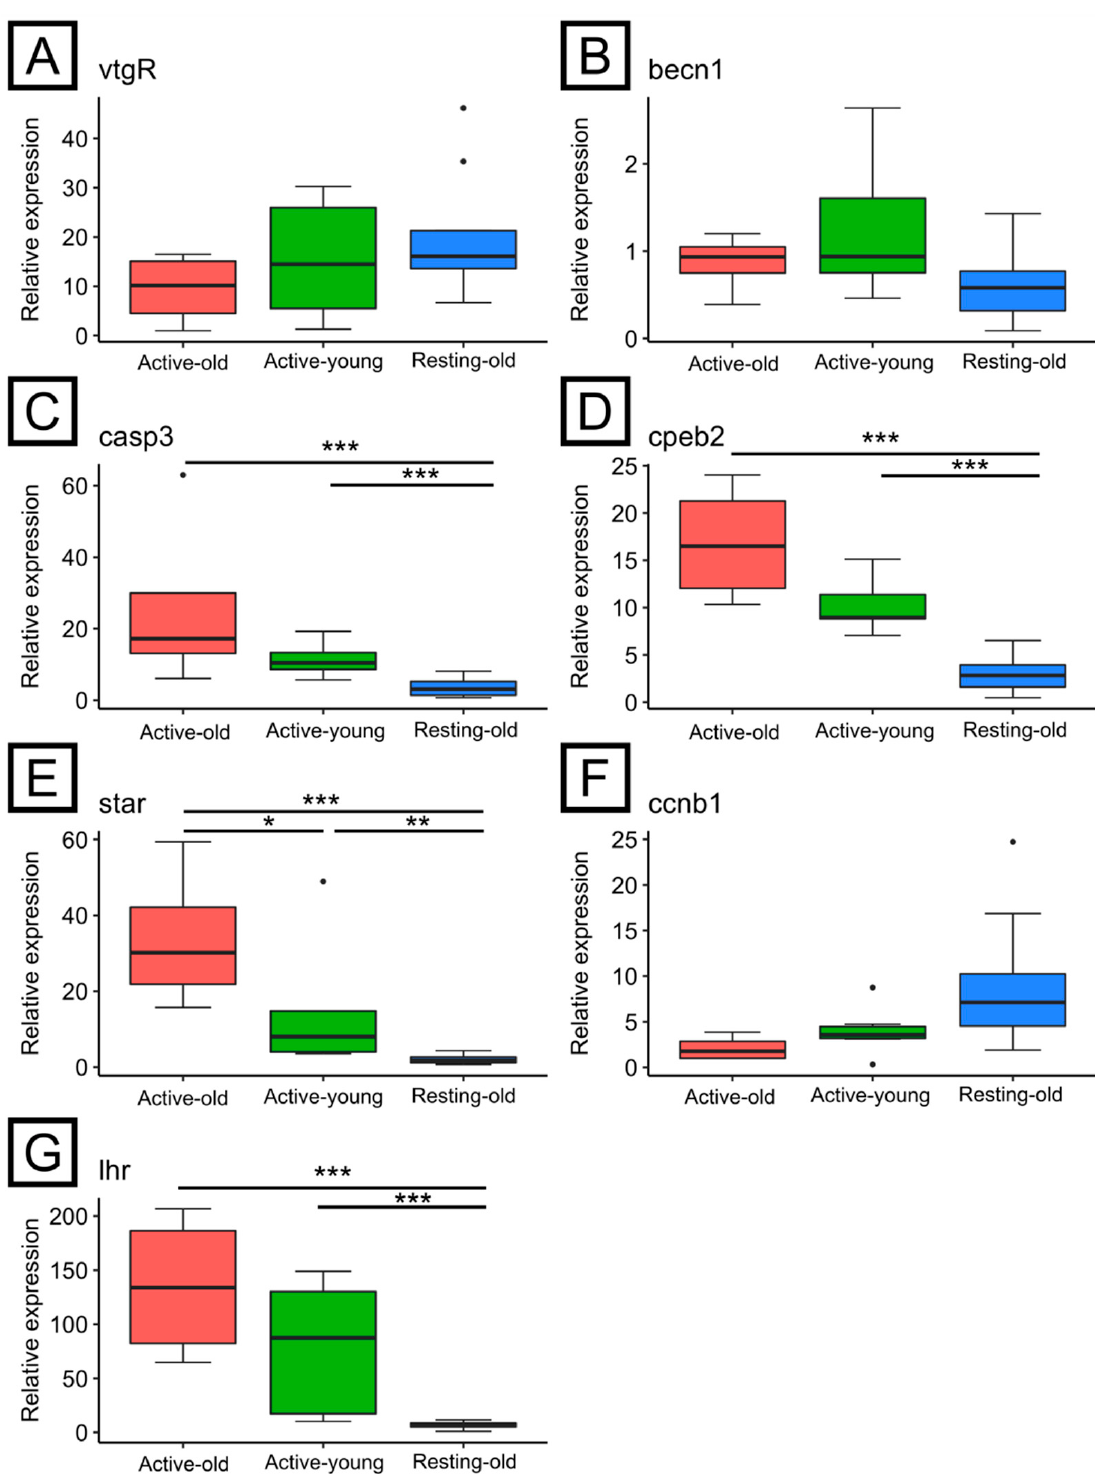
Figure 5. Gene expression profiles of several reproductive markers in the ovary. ( A ) Vitellogenin receptor; ( B ) Beclin 1; ( C ) Caspase 3; ( D ) Cytoplasmic polyadenylation element binding protein 2; ( E ) Steroidogenic acute regulatory protein; ( F ) Ciclin B1; ( G ) Luteinizing hormone receptor. The groups Active-old and Active-young correspond to individuals sampled during the reproductive period while Resting-old group during the non-reproductive period. *** p < 0.001, ** p < 0.01, * p < 0.05.